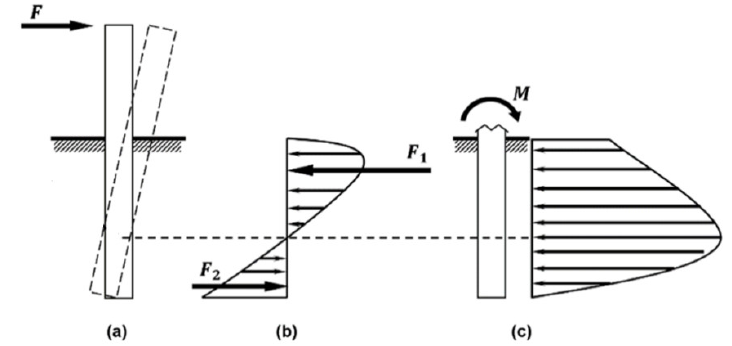
Figure 5. ( a ) Deflection of a rigid monopile when subjected to a horizontal loading; ( b ) representation of generic soil reactions to a rigid monopile; and ( c ) representation of the resulting bending